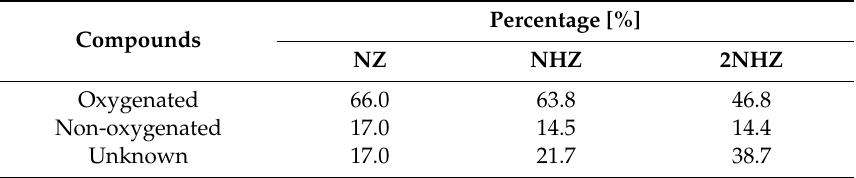
Table 5. Qualitative analysis of bio-oil obtained from catalytic Oak